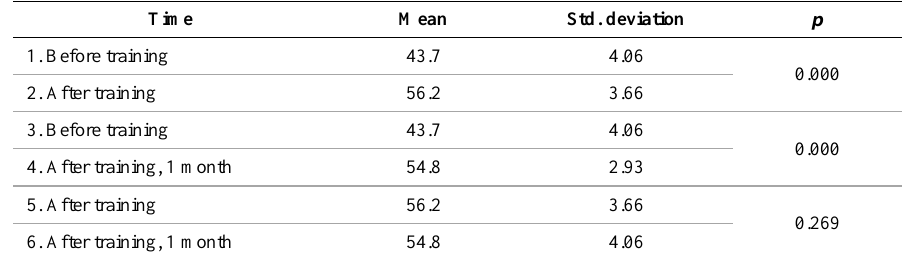
Table 5. The comparison of problem-solving skills of trainees in the implementation of the training model with